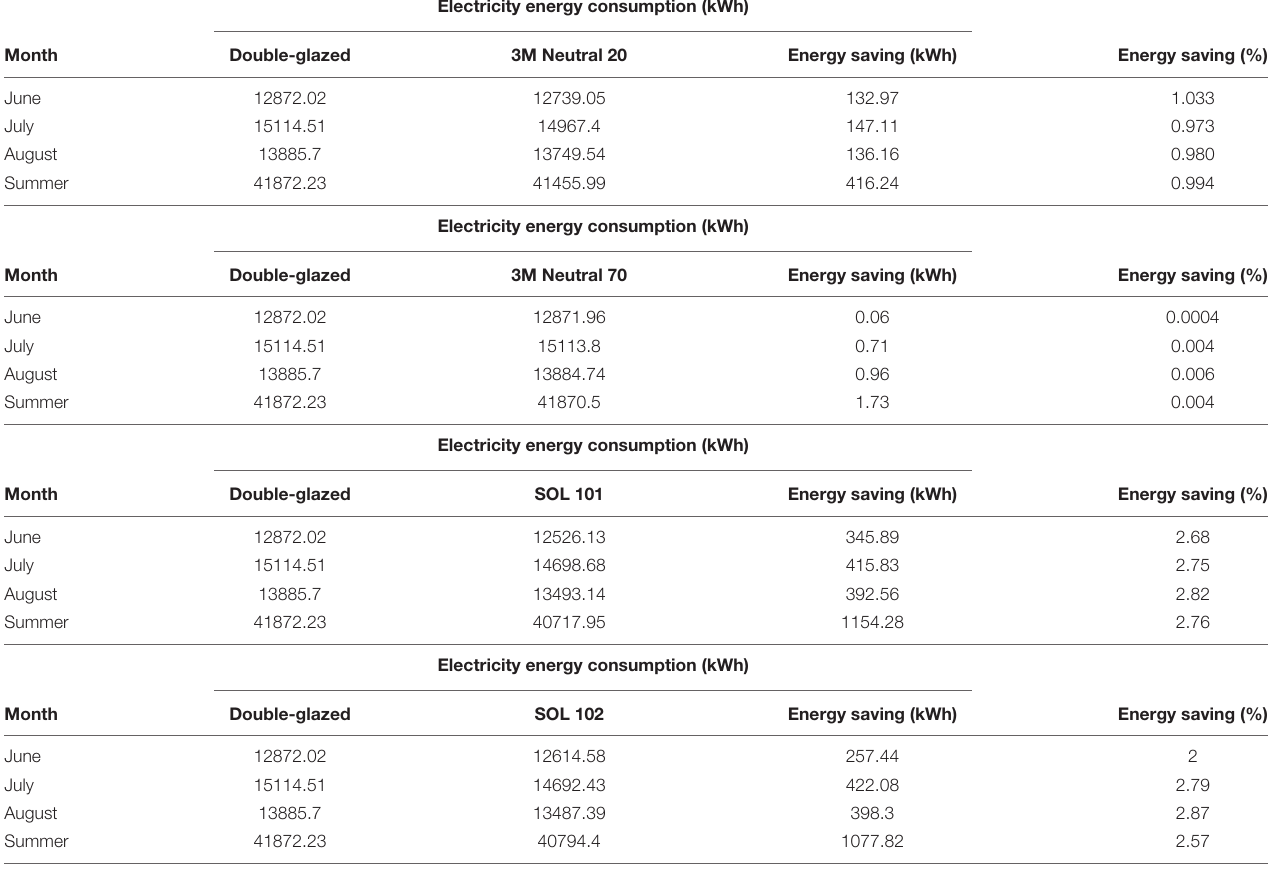
3M Neutral window films in the month of June 2019.